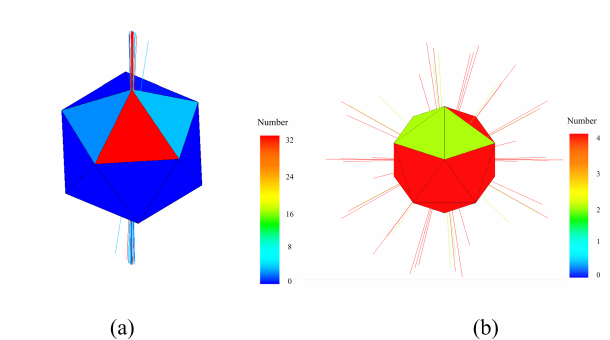
Figure 11: The Eigen-Sphere features of the table surface and the sphere